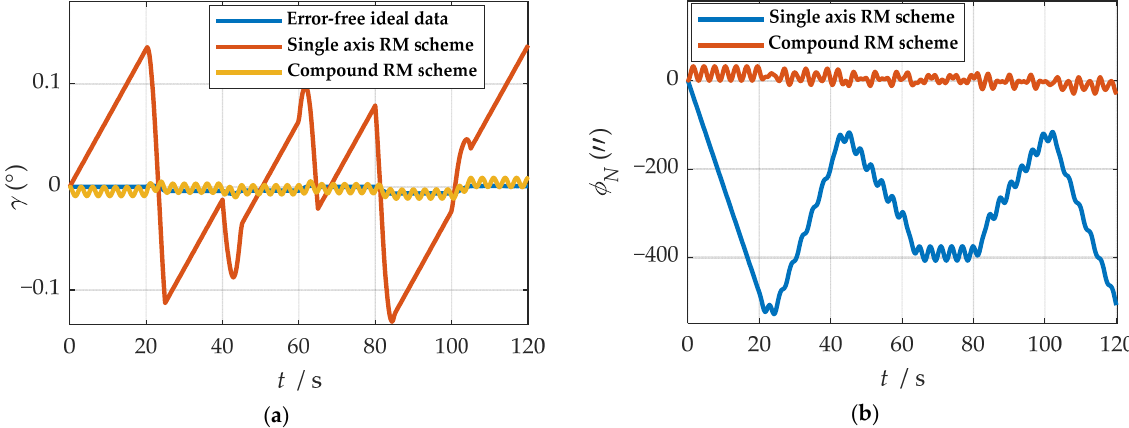
Figure 13. The navigation results comparison of the rotation scheme: ( a ) comparison of calculation results of roll angle; ( b ) comparison of calculation results of north misalignment angle.